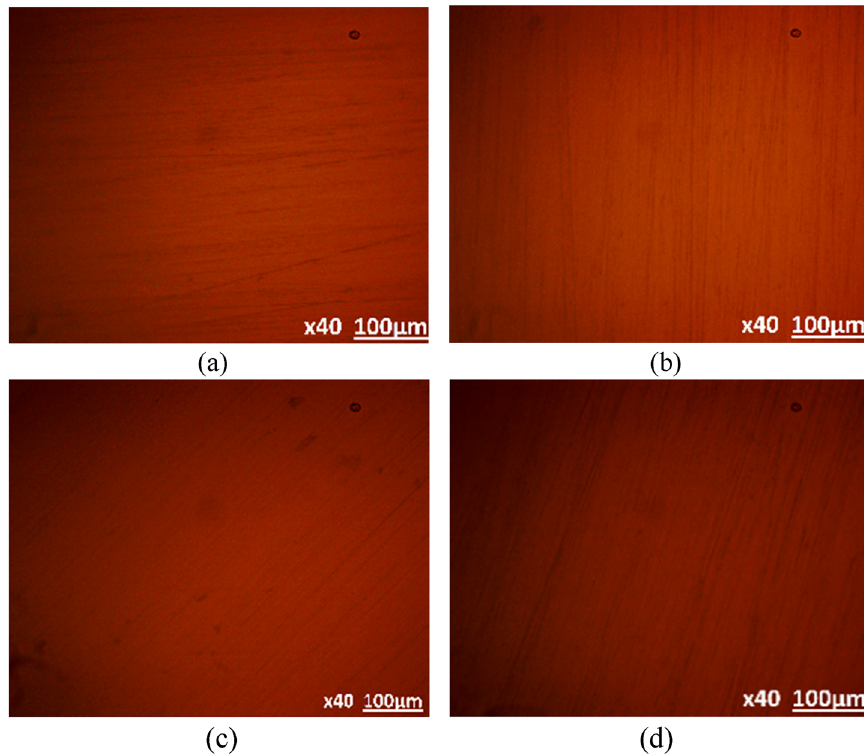
Figure 3: Optical morphology of ( a ) 439ll, ( b ) 316L, ( c ) NO7208, and ( d ) Ti6Al4V before corrosion